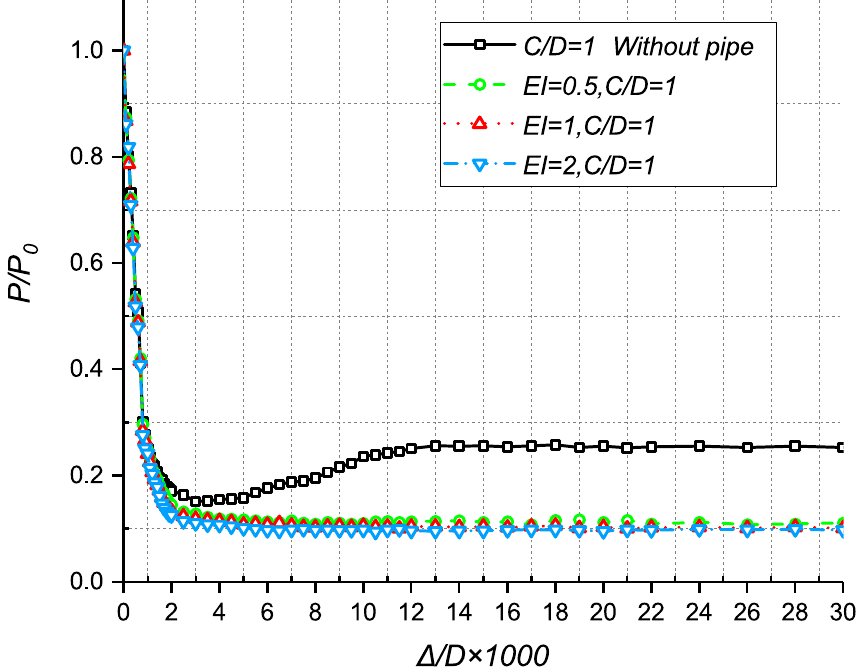
Figure 8. Variation of the normalized pressure on the excavation face ( P / P 0 ) with the face displacement.